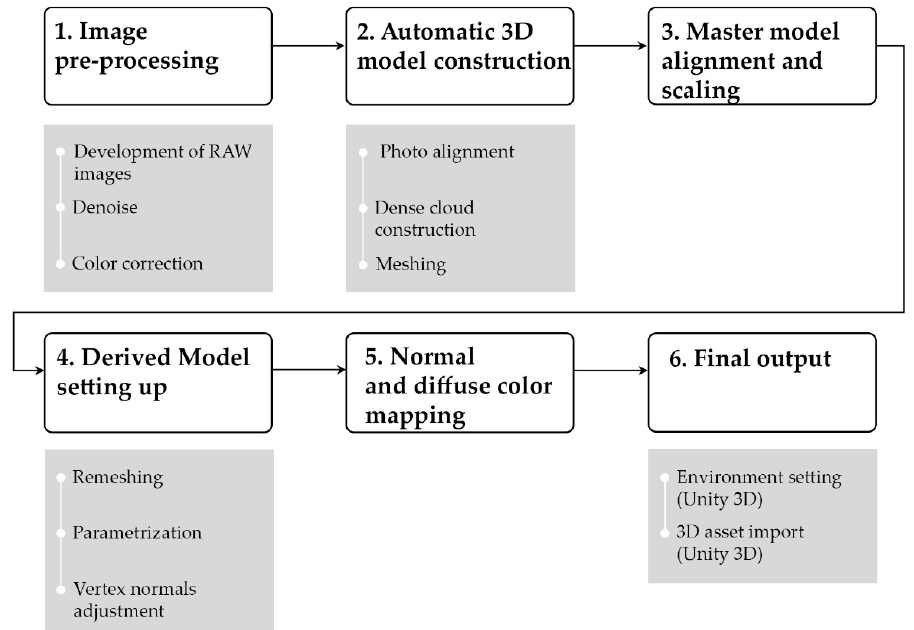
Figure 6. The proposed workflow.